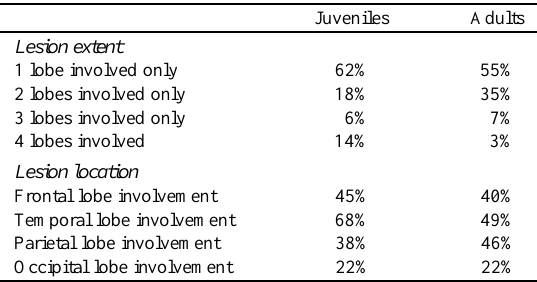
Table 1 Description of the lesions in terms of extent and location for